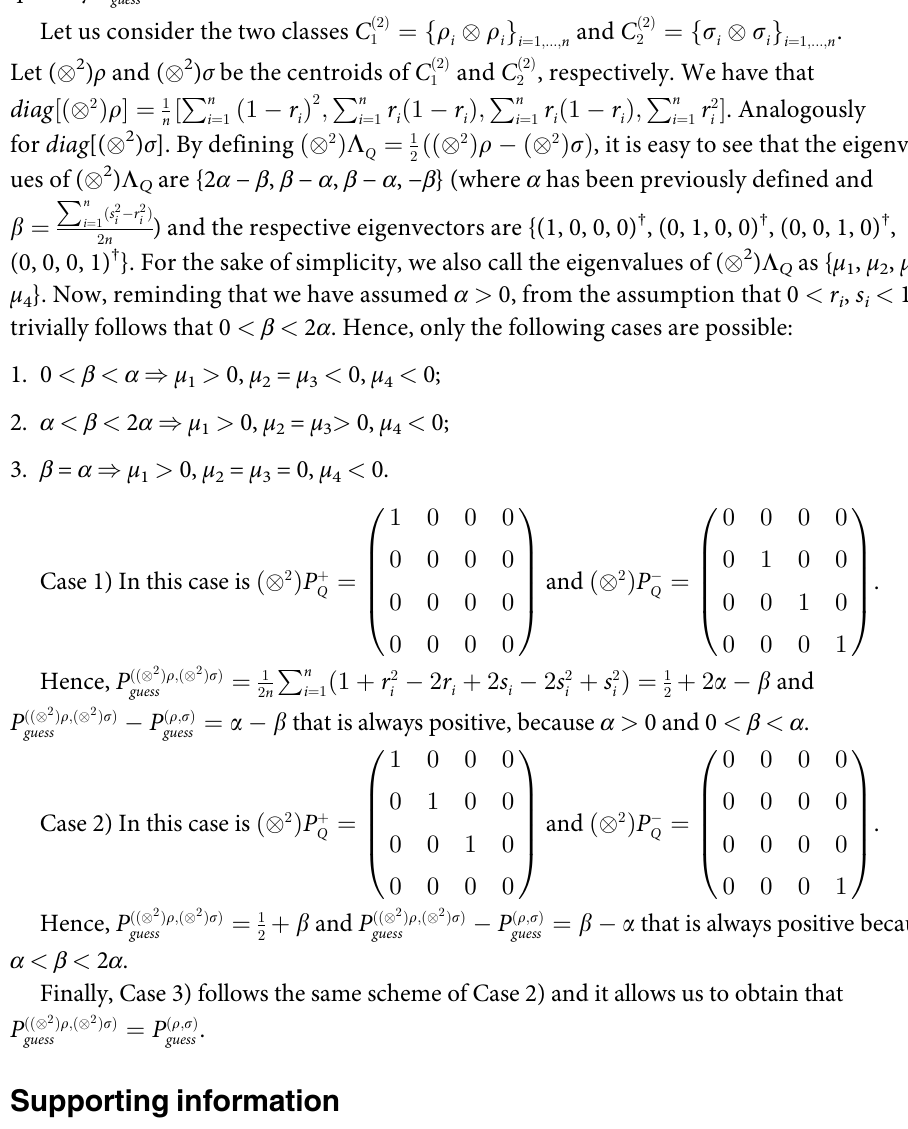
S1 File. Table A. Banana dataset (with # n number of copies). Table B. Prnn-synth dataset (with # n number of copies). Table C. Analcatdata aids dataset (with # n number of copies). Table D. Haberman dataset (with # n number of copies). Table E. Moon dataset (with # n num- ber of copies). Table F. Lupus dataset (with # n number of copies). Table G. GaussianPlos data- set (with # n number of copies). Table H. Titanic dataset (with # n number of copies). Table I. Analcatdata-boxing1 dataset (with # n number of copies). Table J. Analcatdata-asbestos